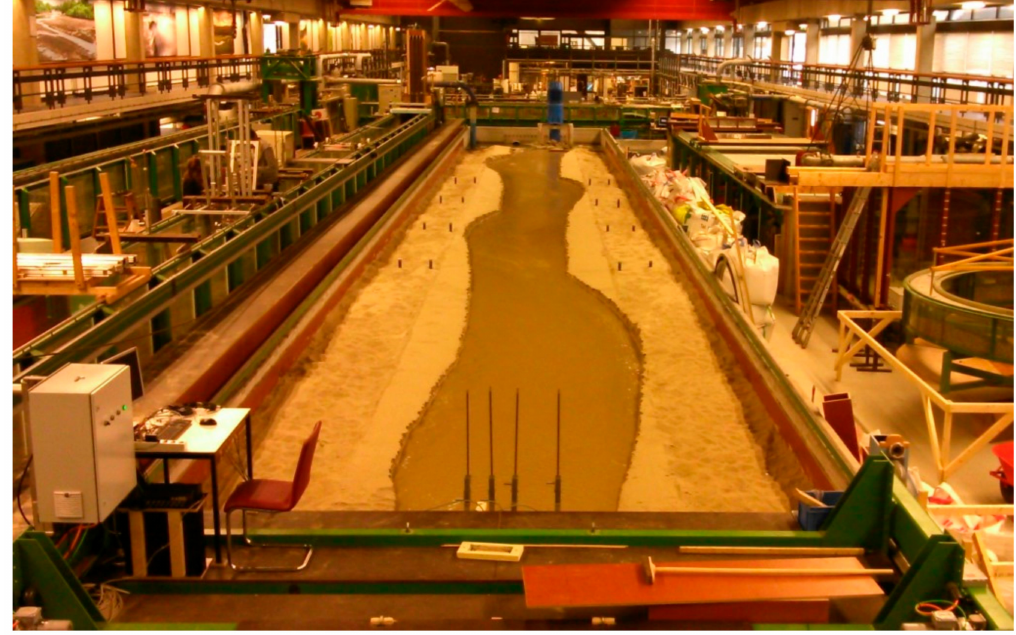
Figure 7. Alternate bars enhance opposite bank erosion (courtesy of Andr é s